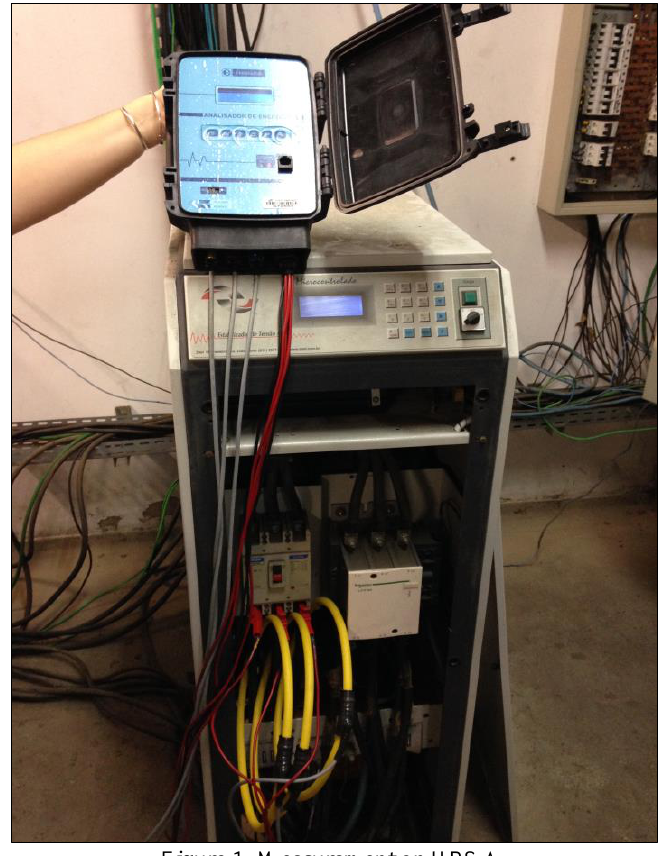
Figure 1: Measurement on UPS